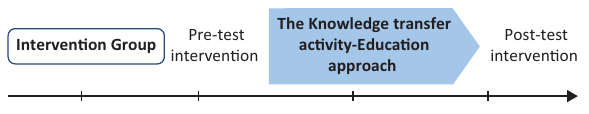
FIGURE 2: The activity flow of flood-risk education intervention programme.